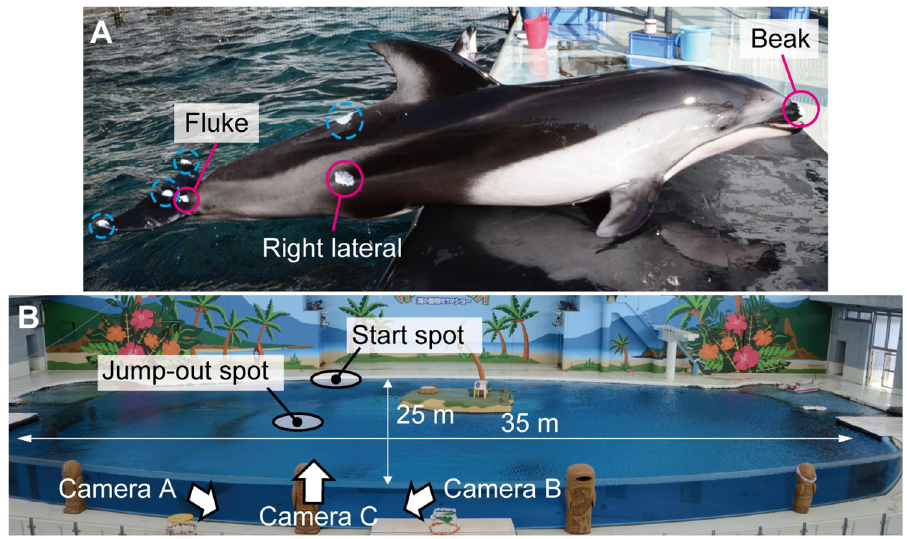
Fig 1. Video recording setup. (A) The Pacific white-sided dolphin ( Lagenorhynchus obliquidens ) recorded in this study. White ointments were painted as markers for motion tracking. Beak, lateral, and fluke markers indicated by solid magenta circles were used in this study, while the other markers indicated by dotted cyan circles were not used. (B) Overview of the water tank at Yokohama Hakkeijima Sea Paradise. The water depth is 6 m. The high-speed video cameras do not appear in this photo. Instead, positions and directions of the cameras are indicated with white arrows. The floating island in this photo was removed when the dolphin performed the jump.